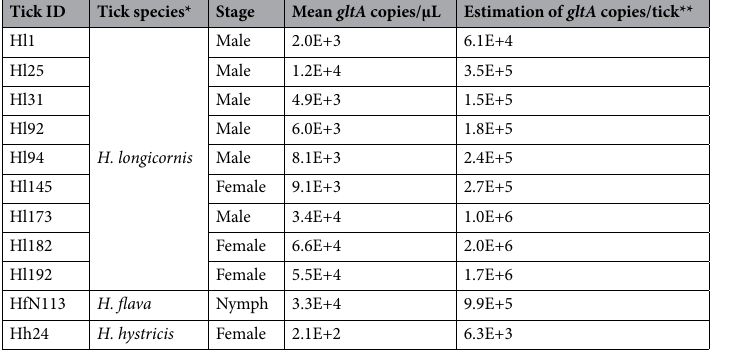
Table 3. The gltA copy numbers of uncultured Ehrlichia bacteria in ticks by qPCR. * H : Haemaphysalis . **The gltA copy numbers in a single tick were estimated by the multiplication of mean gltA copies/µL determined and DNA elution volume (30 µL).